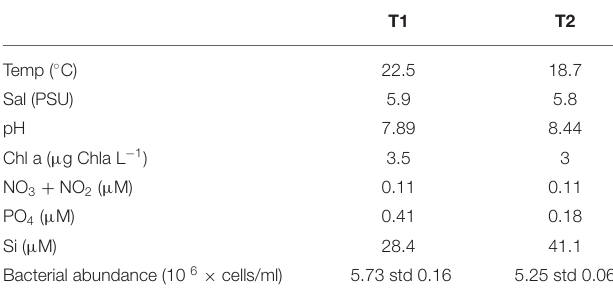
TABLE 1 | Environmental parameters at sampling